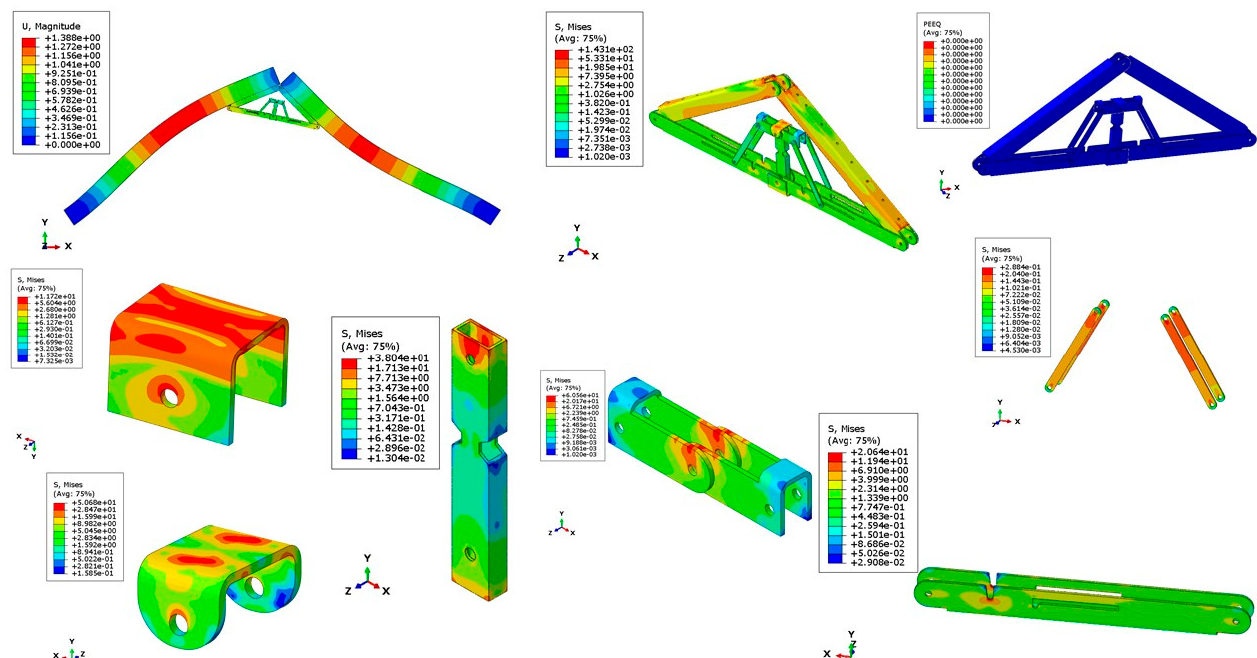
Figure 32. Stress (MPa) in different parts for partial snow load case (specified snow load of 2.25 kPa).